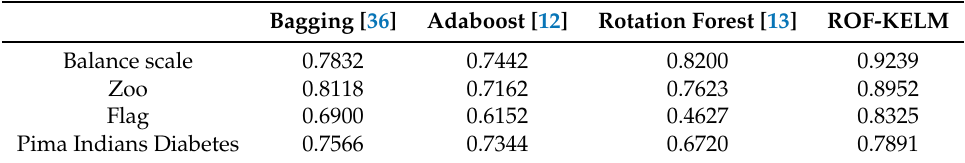
Table 6. The overall accuracy of UCI data